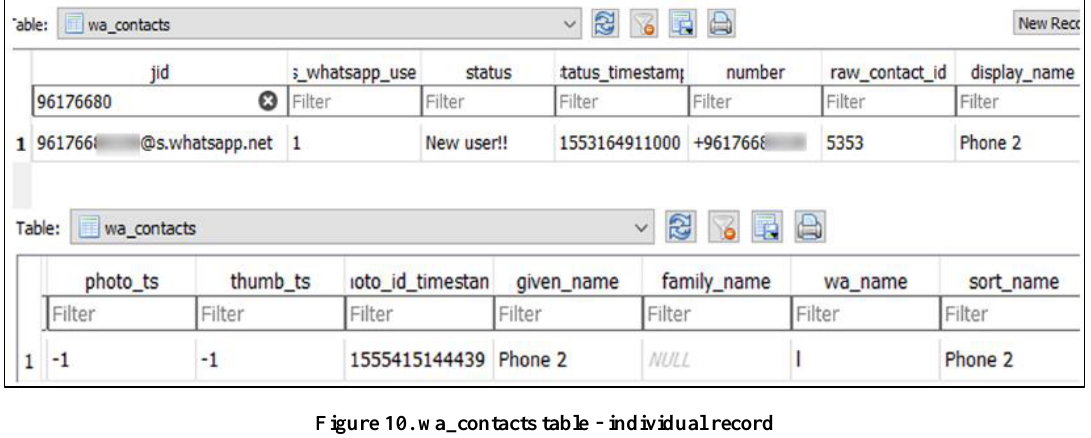
Figure 10. wa_contacts table - individual record